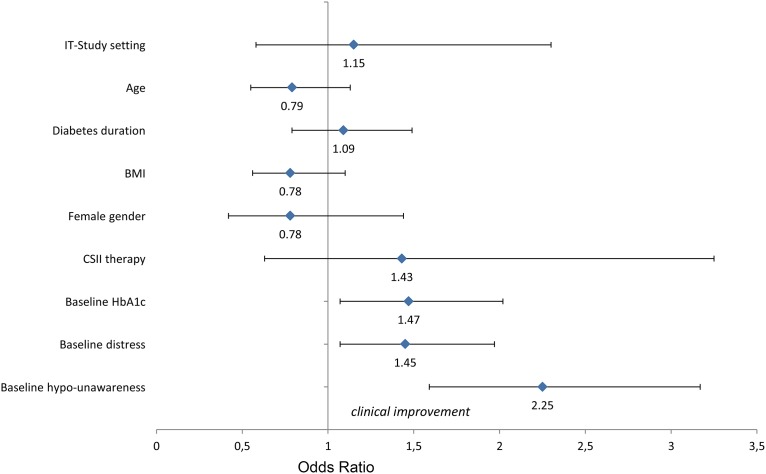
Odds ratios for clinical improvement in glycaemic control, hypoglycaemia awareness and/or diabetes-related distress (continuous variables: odds ratio per 1 standard deviation increase).* p < .05.